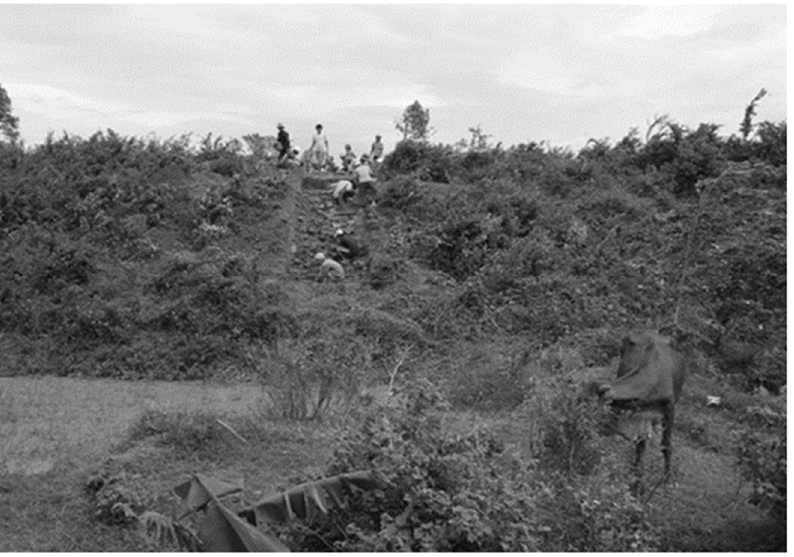
Figure 2. Edge of H ồ Citadel, Blended into Edge of Agricultural Landscape and the Local Forest (Photograph by Qu ả ng V ă n S ơ n).